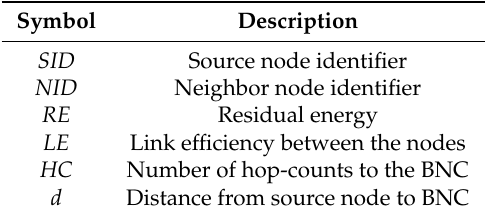
Table 1. HP header fields in ELR-W